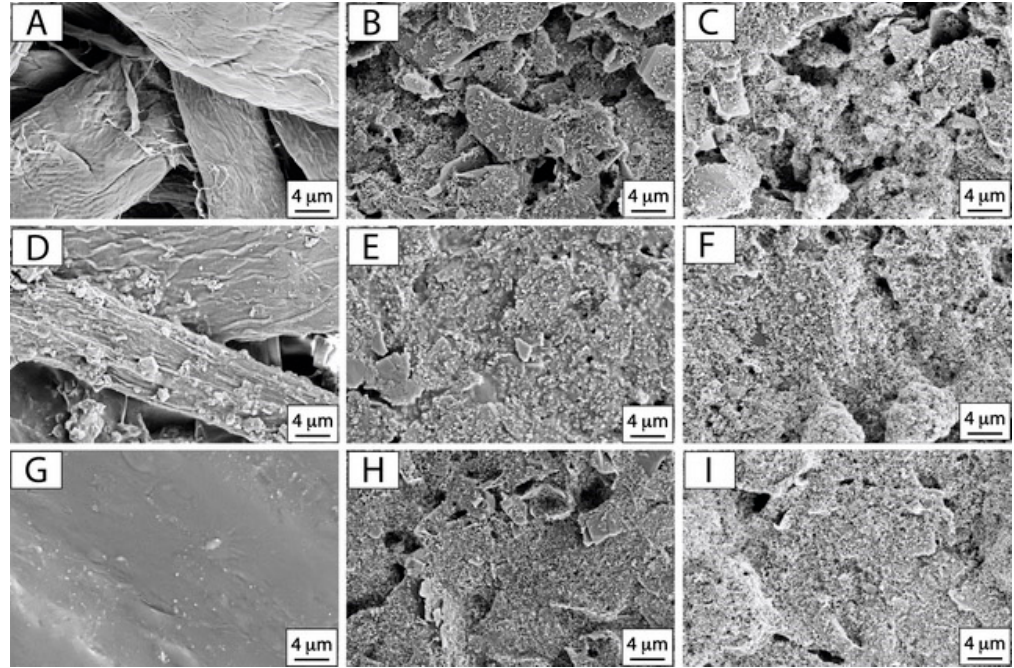
Figure 2. SEM micrographs of: pristine ( A ) paper towel, ( D ) waxed paper, ( G ) Parafilm M ® ; SPEs onto ( B ) paper towel, ( E ) waxed paper, ( H ) Parafilm M ® ; CB modified SPEs onto ( C ) paper towel, ( F ) waxed paper, ( I ) Parafilm M ® . Acceleration voltage: 5 keV, magnification 10 kx.